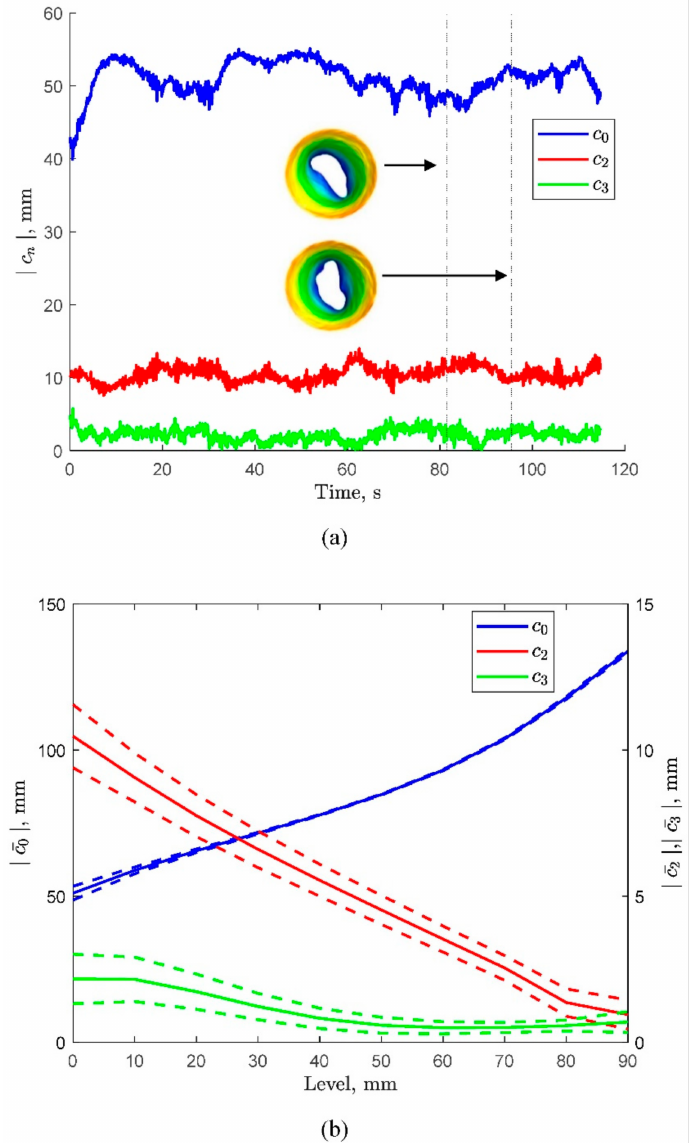
Figure 13. The Fourier coefficients, c 0 to c 3 for 3.4 Hz rotating disk frequency: ( a ) the Fourier coefficients as function of time at the surface of the rotating disk. ( b ) The average and standard deviation of the Fourier coefficients for the time interval presented in ( a ) at different heights above the rotating disk. The left vertical axis corresponds to c 0 and the right vertical axis corresponds to c 2 and c 3